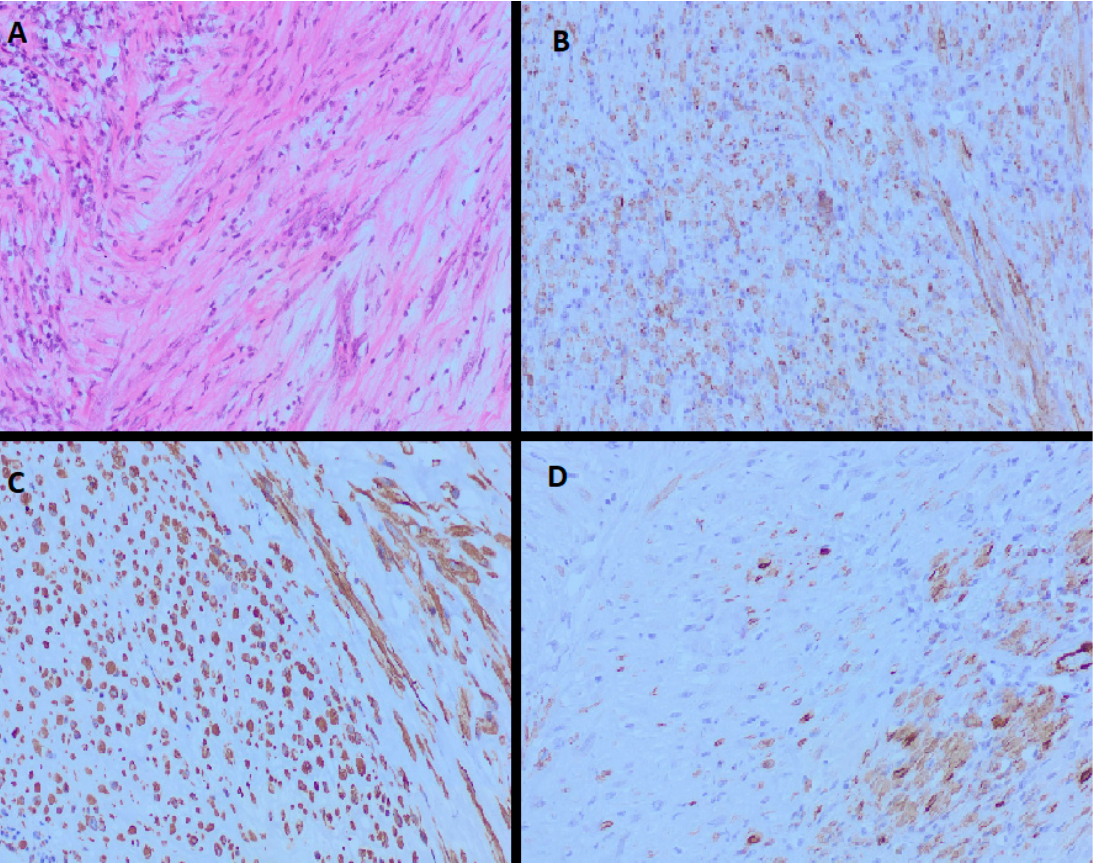
Figure 1. Histopathological findings showed that the tumorous mass consists of spindle cells with mixed inflammatory infiltrate ( A ). Immunohistochemical findings showed positivity for anaplastic lymphoma kinase (ALK) ( B ), vimentin ( C ) and smooth muscle actin (SMA) ( D ).